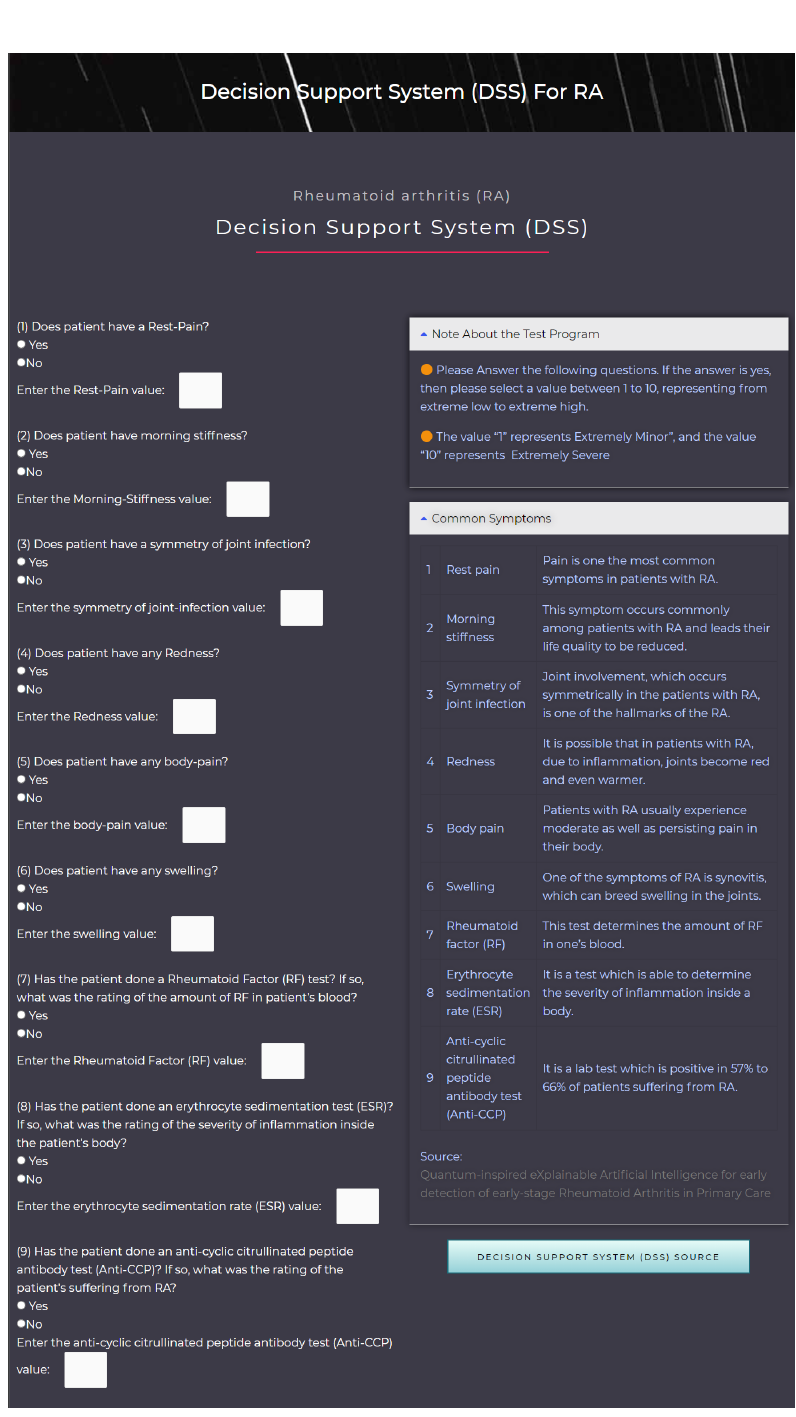
Figure 5. The DSS FL interface for taking user input.